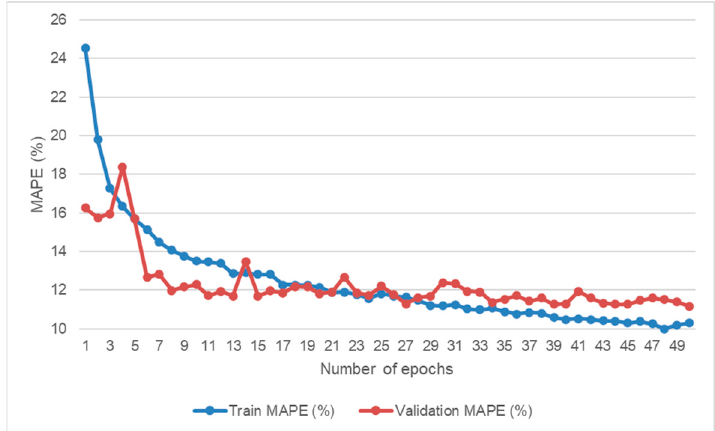
Figure 10. Training and validation MAPE during the RNN